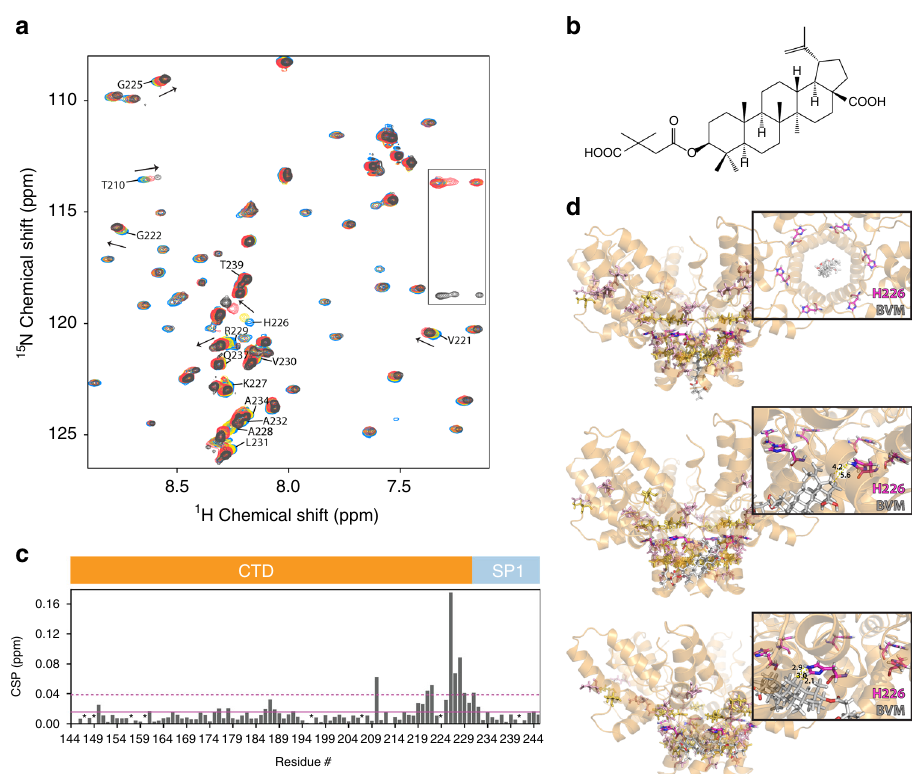
Fig. 2 Solution NMR and rigid body docking of Bevirimat binding to CTD – SP1. a Superposition of selected region of the 1 H- 15 N HSQC spectra of 0.4 mM CTD – SP1 in the absence (blue) and presence of 1.11 mM (yellow), 2.22 mM (red), and 3.33 mM (black) Bevirimat at 298 K. Representative CTD – SP1 resonances are labeled with residue names and numbers. Folded arginine side chain N ε resonances are enclosed in the rectangle. b 1 H, 15 N-combined chemical shift perturbations (CSP) for CTD – SP1 resonances in the absence and presence of Bevirimat (3.33 mM), respectively. The solid and dashed horizontal lines indicate the average chemical shift change (0.016 ppm) and the sum (0.038 ppm) of the average change plus one S.D., respectively. Proline residues and the unassigned S149 positions are marked with *. Note the large CSPs observed for resonances of residues 219 – 233 are indicative of the interaction between Bevirimat and CTD – SP1. c Chemical structure of Bevirimat. d Binding poses of BVM (gray) in the CTD – SP1 hexamer (X-ray structure PDB code 5I4T) resulting from rigid body docking. The insets are expansions, illustrating the relative positioning of BVM and the H226 residue (colored magenta). Residues with CSPs > 0.04 and > 0.02 ppm are colored yellow and light pink, respectively. Residues in the CTD – SP1 junction whose resonances experience CSPs > 0.02 ppm are located in the binding interface identi fi ed in the docking